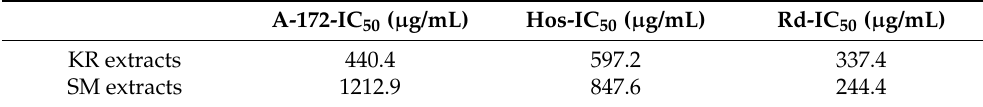
Figure 5. Evaluation of the effect of kudzu roots (KR) and soy molasses (SM) extracts on the viability of glioblastoma (A-172) cells, osteosarcoma (Hos) cells, and human embryonic rhabdomyosarcoma (Rd) cells. Data are shown as mean ± SD. Table 6. Index of cytotoxicity (IC 50 ) of kudzu roots (KR) and soy molasses (SM) extracts.